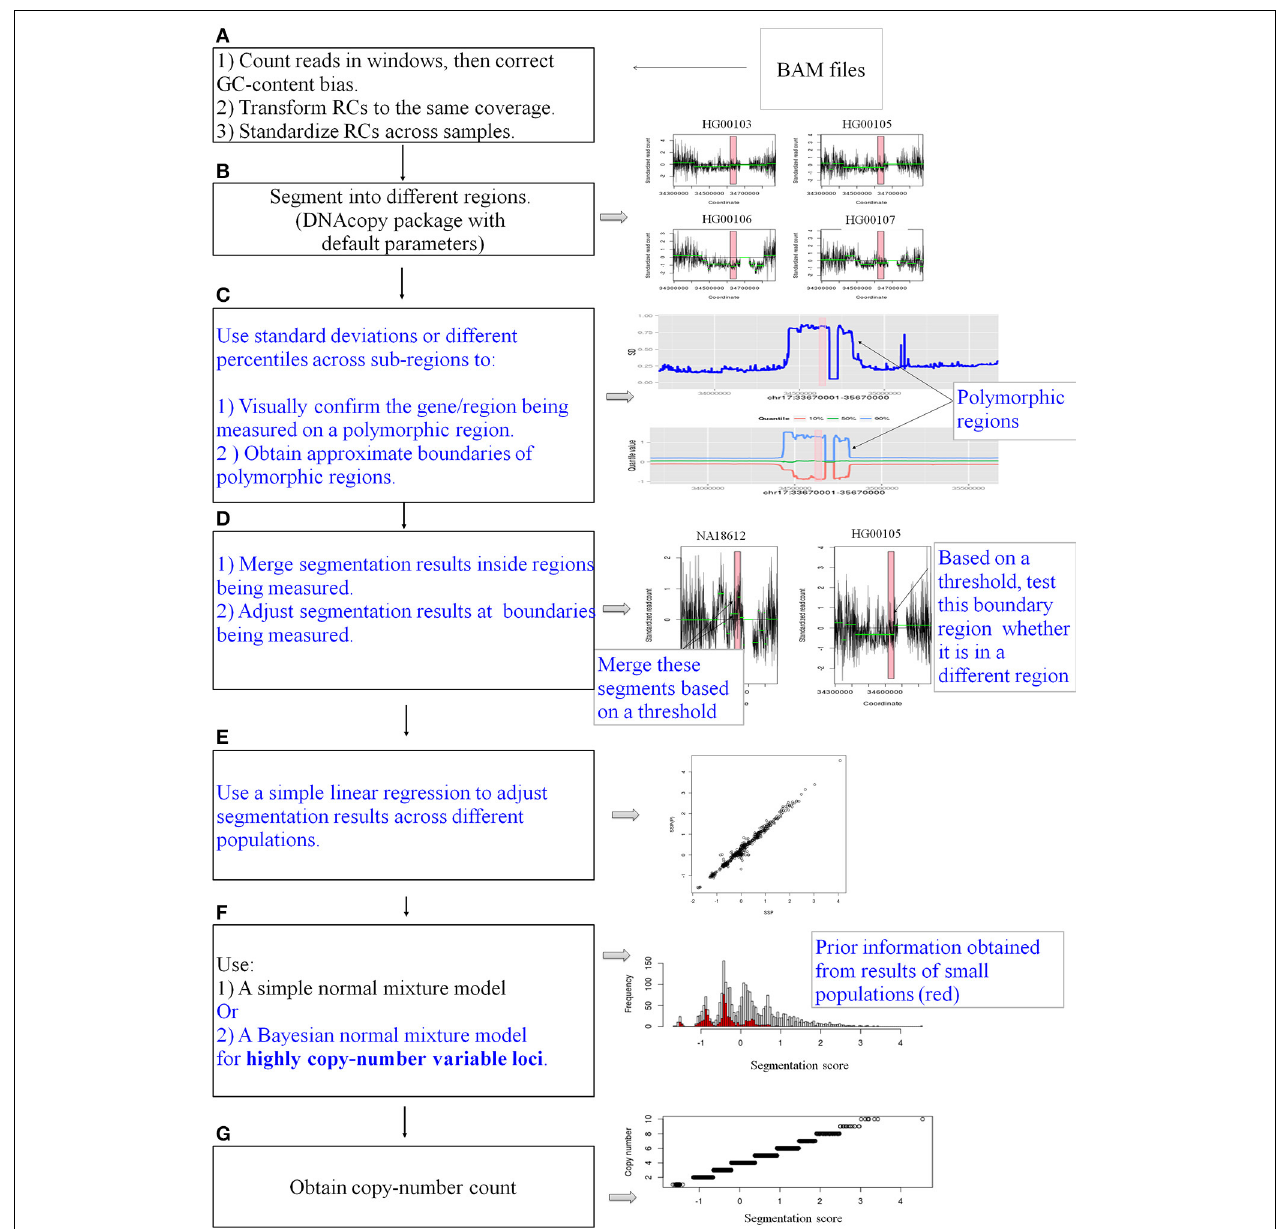
FIGURE 1 | A schematic diagram of the pipeline. CNVrd2 is a modified version of CNVrd. CNVrd2 is identical to CNVrd at the counting, transforming, standardizing and segmenting steps ( A,B,G : black text). However, CNVrd2 has additional steps: identification of polymorphic regions (C) , merging sub-regions inside genes/regions being